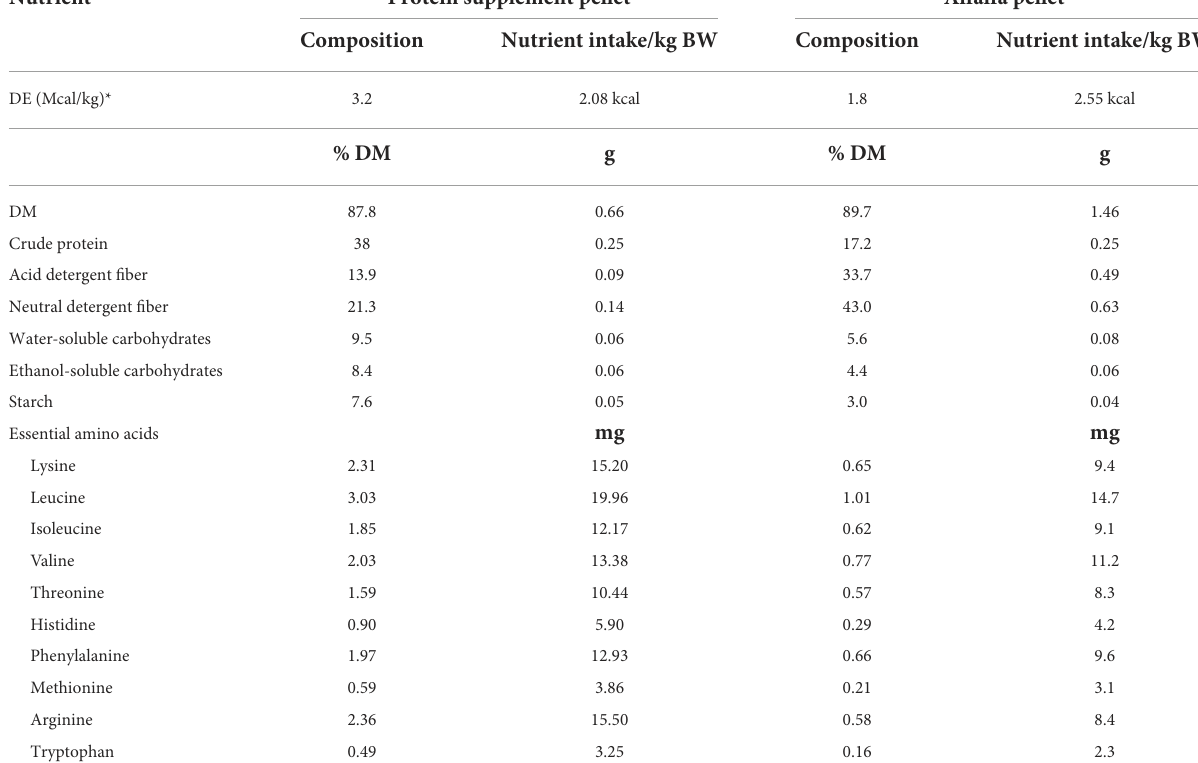
TABLE 3 Nutrient composition (dry matter basis) and macronutrient intake of each treatment pellet. Nutrient Protein supplement pellet Alfalfa pellet